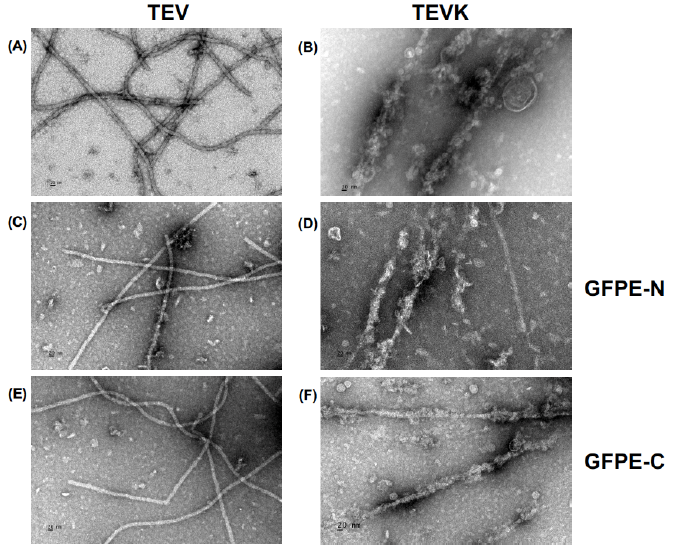
Figure 6. VLP assembly confirmation by transmission electron microscopy. ( A ) Native TEV CP. ( B ) TEVK. ( C ) Native TEV mixed with GFPE-N protein. ( D ) TEVK mixed with GFPE-N protein. ( E ) Native TEV mixed with GFPE-C protein. ( F ) TEVK mixed with GFPE-C protein. Scale bar: 20 nm.